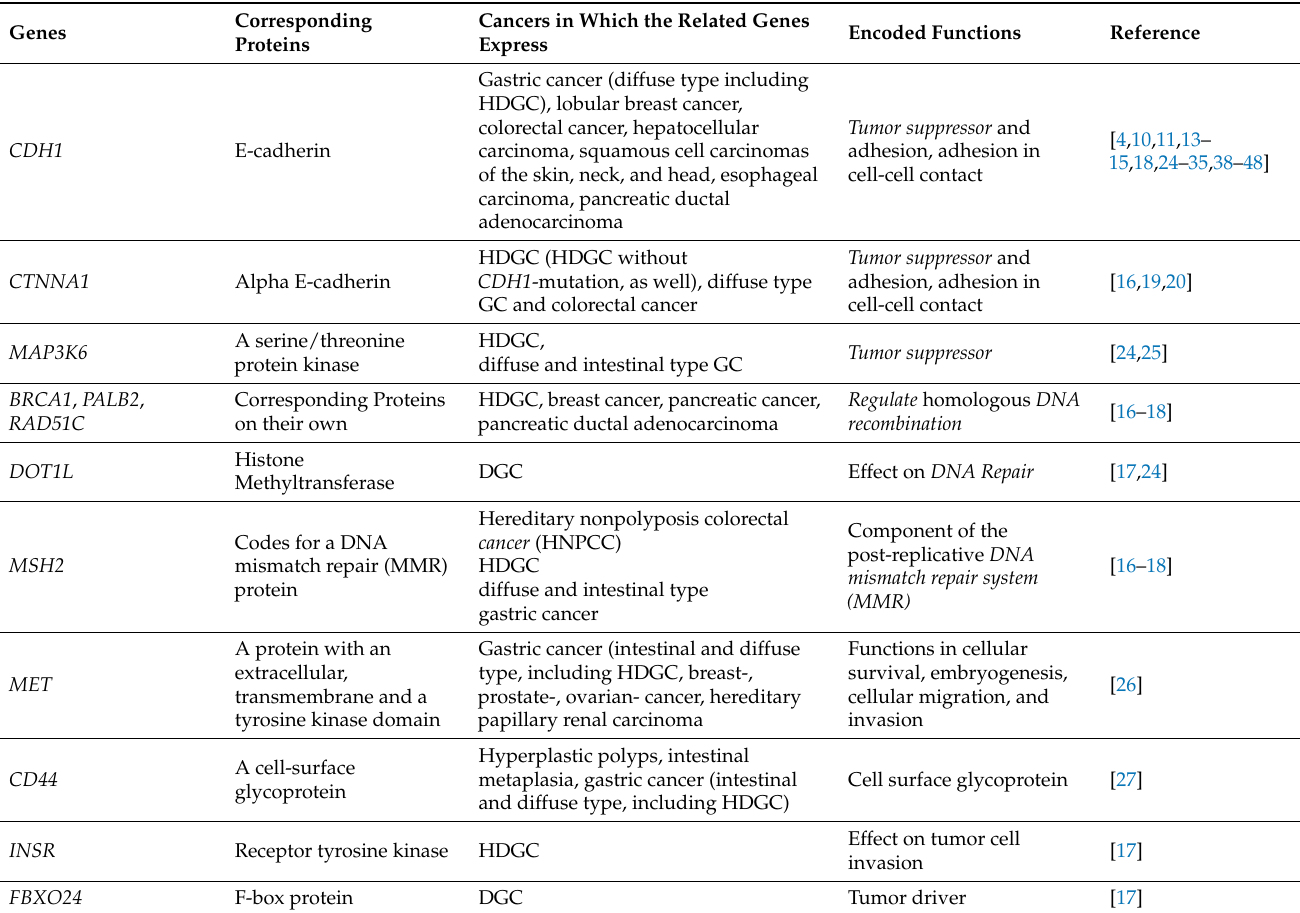
Table 1. Molecular profiling in